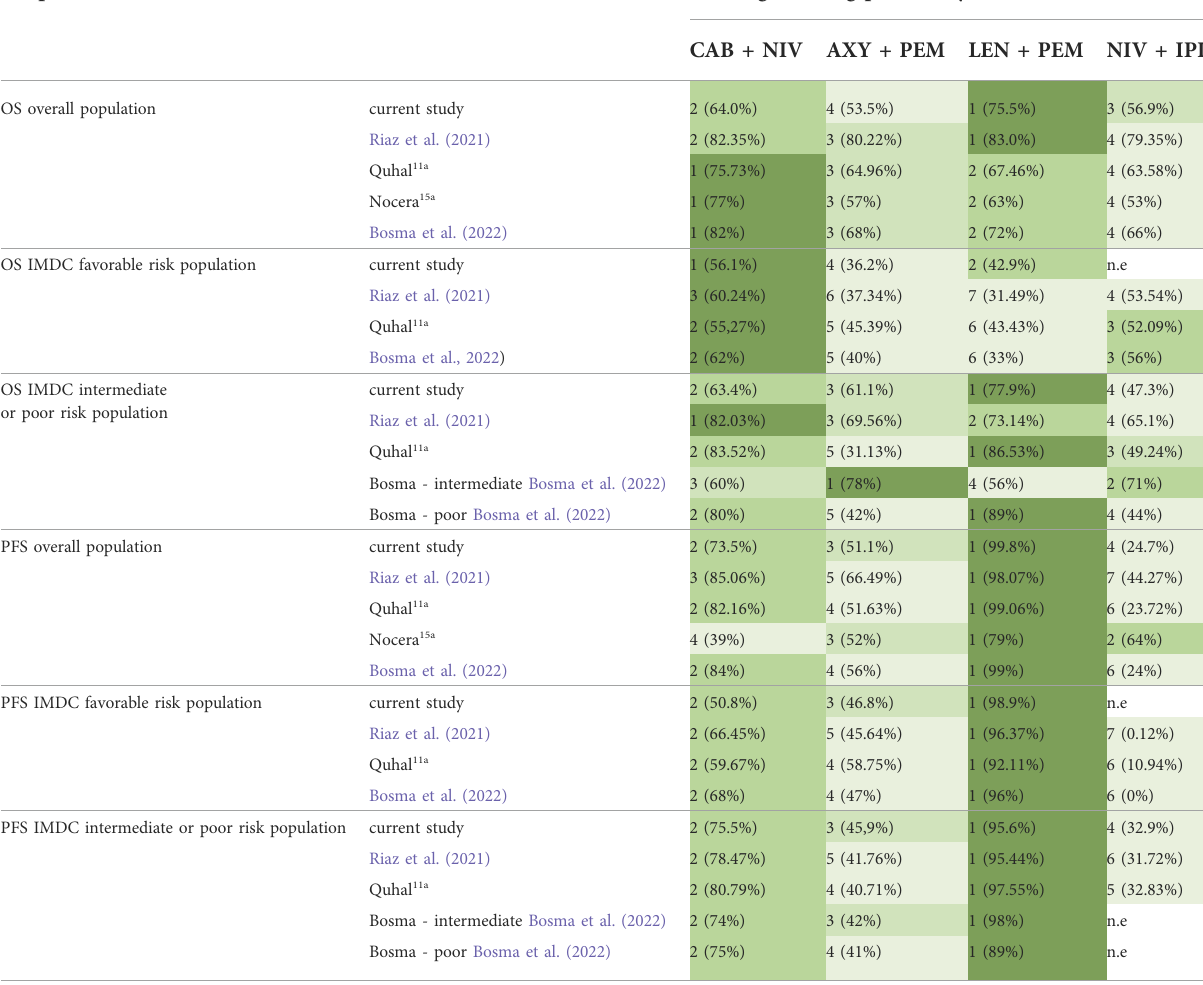
TABLE 9 Rank order (SUCRA) of 1L aRCC combination therapies for OS and PFS across eligible